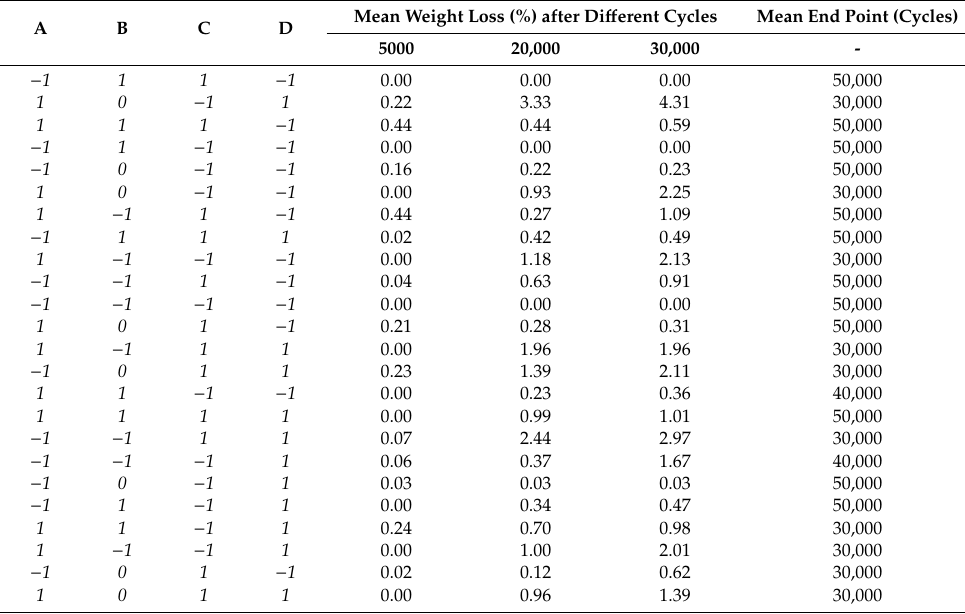
Table A2. Mean weight loss (%) after di ff erent cycles: 1000, 2000, 5000, 10,000, 15,000 and 20,000 and maximum number of cycles (end point). A, B, C and D are the pattern, the weft density, the fabric orientation and the printing bed temperature, respectively.